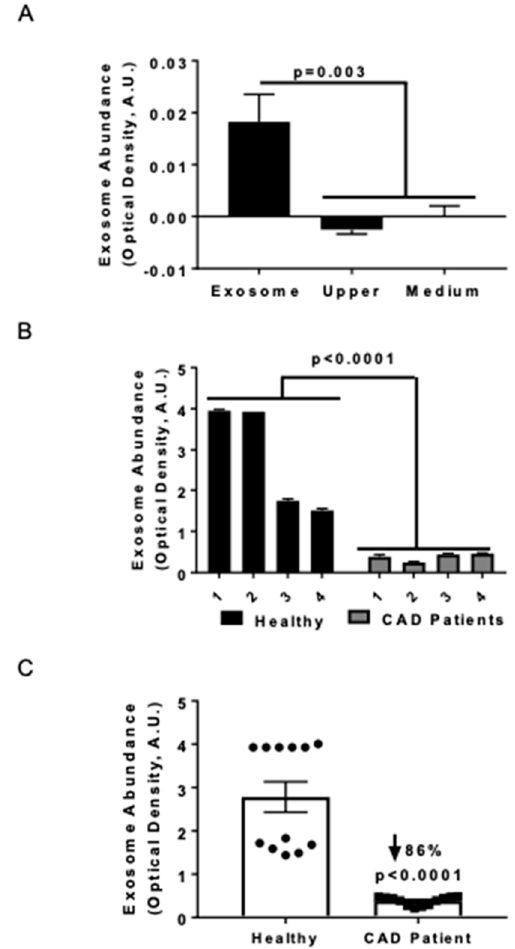
Figure 1. Serum exosome levels in coronary artery disease (CAD) patients are diminished compared with healthy controls. Exosome abundance was assessed by ELISA and quantified by optical density using arbitrary units obtained after background subtraction (A.U.). ( A ) ELISA performed with anti-MHC primary (capture) antibody and anti-CD81 antibody to detect exosomes in the purified fractions ( n = 4) from THP1 M Φ . Horizontal axis labels: Exosome = Purified exosome fraction; Upper = the upper fraction without exosomes after ultracentrifugation; Medium = cell culture medium (only) as negative control. ( B ) Detection of serum exosomes in CAD patients and healthy (control) subjects. Anti-CD81 was applied as the capture antibody and anti-MHC-II was used as the developing antibody to quantify exosomes in each sera sample. Analysis was performed via two-way ANOVA ( n = 4 subjects per group, with each subject’s sample measured in triplicate). ( C ) Detection of exosomes in the sera of CAD patients and healthy individuals (control). Anti-CD81 was applied as the capture antibody and anti-MHC-II was used as the developing antibody to quantify exosomes in each sera sample. The data were analyzed using a Mann-Whitney test and plotted to note the exosome distribution in each population. Exosome levels were downregulated in CAD patients.